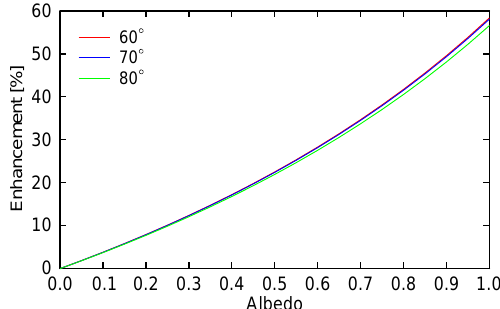
Figure 2. Enhancement of the clear-sky UVI as a function of albedo. The plot is based on radiative transfer calculations with the libRadtran model (Mayer and Kylling, 2005) for sea level, a TOC of 400 DU, and SZAs of 60, 70 and 80 ◦ as indicated in the